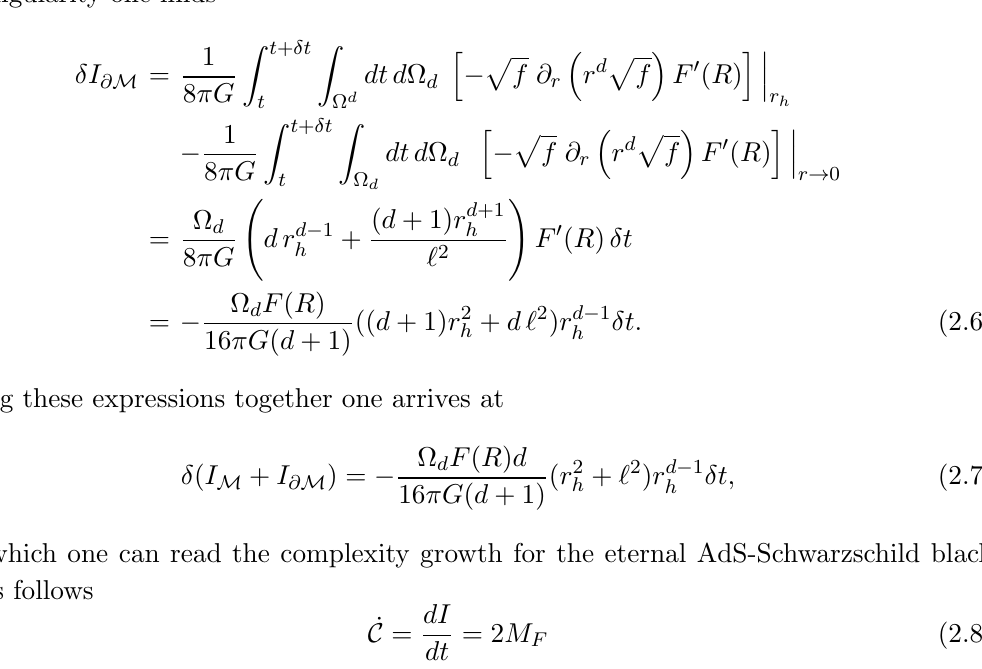
Figure 1 . Two nearby Wheeler-de Witt patches at t and t + (cid:14)t and the part that contributes to the late time behavior of complexity growth. This (cid:12)gure is drown from (cid:12)gure 2 of [12]. On the other hand from the generalized Gibbons-Hawking term evaluated at the